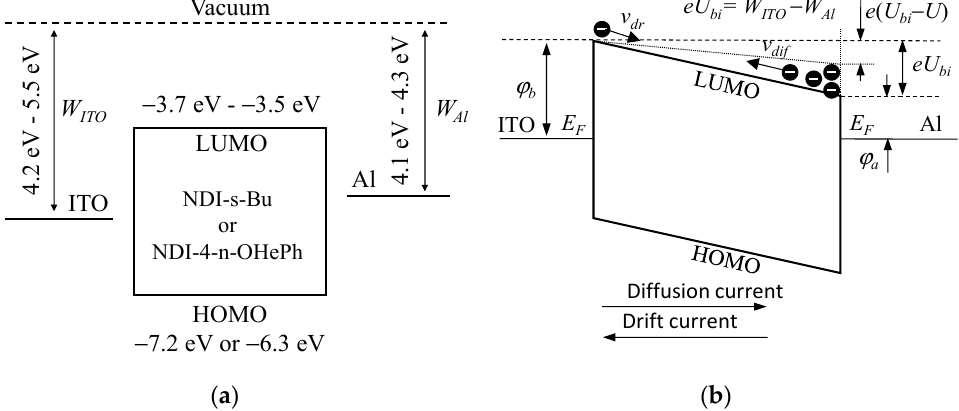
Figure 4. Energies of the HOMO and LUMO levels for the tested naphthalene dimides and the ranges of the ITO and Al electrode work function taken from literature reports; ( a ) energy diagram for electron-only device with two blocking electrodes in thermal equilibrium and upon applying negative bias voltage U (dotted line). ( b ) The energy barriers for the injected electrons from the electrodes are φ b and φ a . The symbol U bi denotes the built-in voltage, and the arrows indicate the directions of the electron velocity and the directions of the drift ( ν d ) and diffusion ( ν dif ) currents.